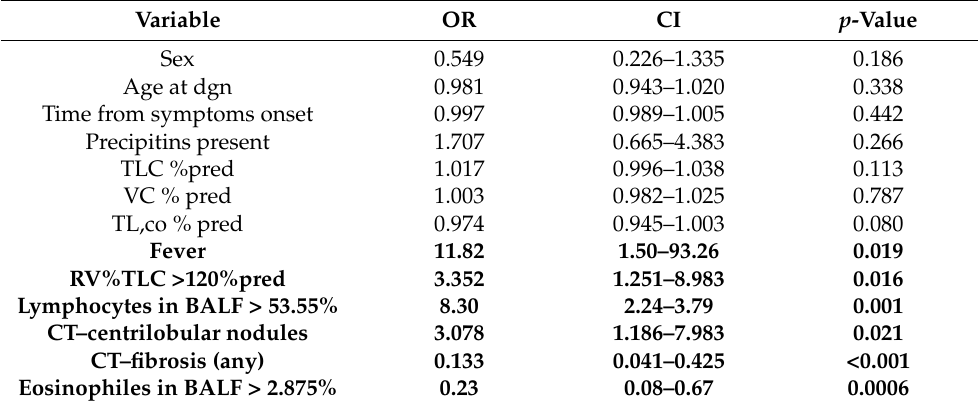
Table 4. Treatment outcome predictors (univariate logistic regression analysis).